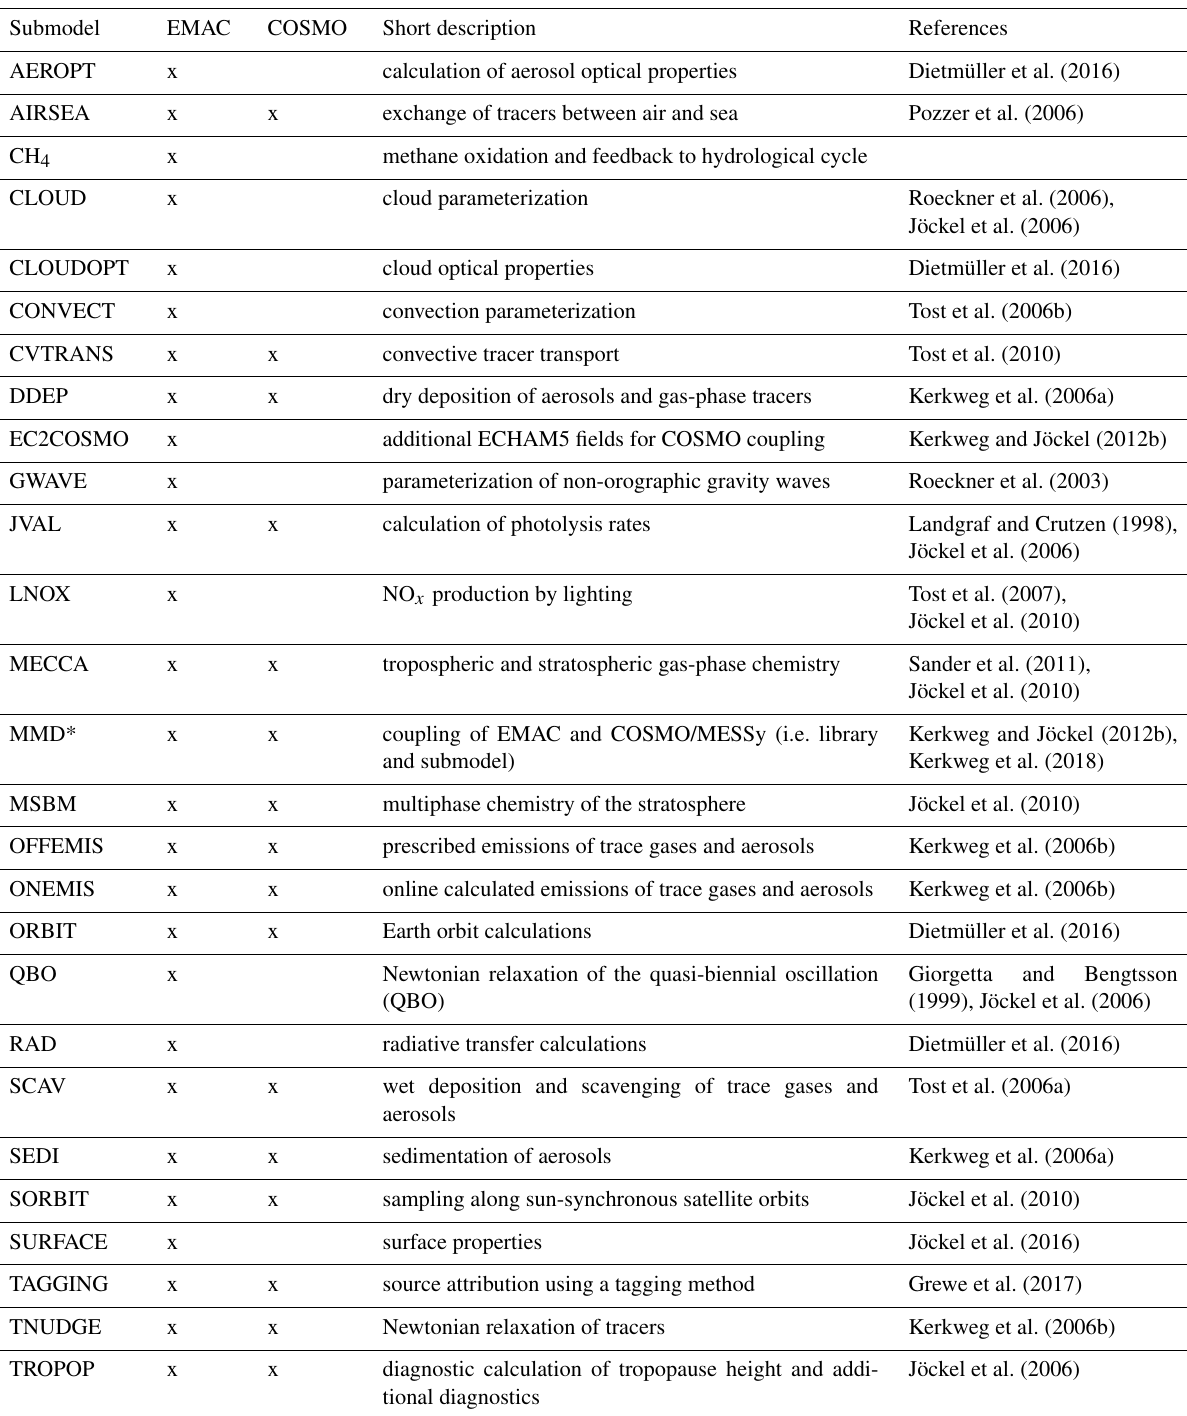
Table 2. Overview of the most important MESSy submodels applied in EMAC and COSMO/MESSy. Both COSMO/MESSy instances use the same set of submodels. MMD ∗ comprises the MMD2WAY submodel and the MMD (Multi-Model-Driver)